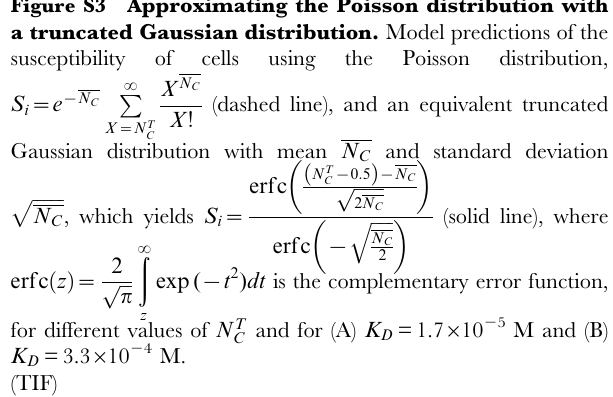
for different values of N T and for (A) K D =1.7 6 10 2 5 M and (B) C K D = 3.3 6 10 2 4 M. Figure S4 Comparisons of model predictions with data using different values of K D . (A) The fit in Fig. 3B repeated with K D = 1.7 6 10 2 5 M (thick solid line), 3.3 6 10 2 5 M (thin solid line), 1.7 6 10 2 4 M (dashed line), and 3.3 6 10 2 4 M (dotted line). The resulting best-fit parameter estimates are in Table S1. (The fits for different K D nearly overlap and are indistinguishable.) (B) Fits in Fig. 3C repeated with the above values of K D . The resulting best-fit parameter estimates are in Table S2. (C) The comparison in Fig. 3D repeated with the above values of K D and other parameter values in Table S1. Figure S5 Fits without the pseudo-steady state approx- imation. The pseudo-steady state approximation is relaxed and our model predictions (Eqs. (1)–(5)) are fit to the data in Fig. 3B using the parameter estimates in Table S1 and with viral clearance rate c as an adjustable parameter. Initial conditions used are: T (0) =3.7 6 10 4 cells; V (0) =400 ffu ? ml 2 1 ; T d (0) = I (0) =0. The resulting estimates of c are 21.4, 22.7, 23.2 and 23.8 d 2 1 for K D ~ 1.7 6 10 2 5 , 3.3 6 10 2 5 , 1.7 6 10 2 4 , and 3.3 6 10 2 4 M, respectively. (The fits for different K D nearly overlap and are indistinguishable.) Figure S6 Susceptibility of cells predicted using differ- ent best-fit parameter combinations. Dependence of S i on CD81 expression predicted using the parameter combinations in (A) Table S1 and (B) Table S2 where K D = 1.7 6 10 2 5 M (thick solid line), 3.3 6 10 2 5 M (thin solid line), 1.7 6 10 2 4 M (dashed line), and 3.3 6 10 2 4 M (dotted line).